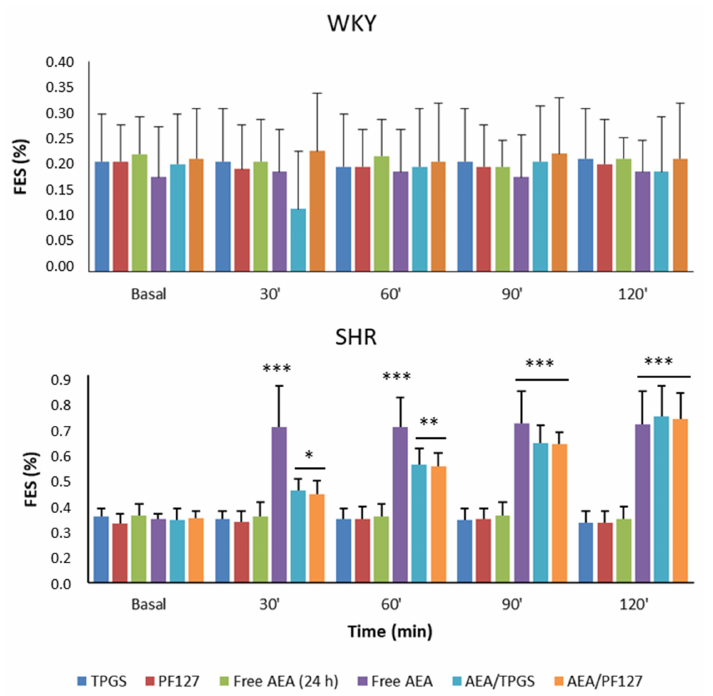
Figure 8. Percentage of the fractional excretion of sodium, measured in WKY and SHR rats, at basal conditions (control) as well as at 30, 60, 90, and 120 min after the injection of different treatments: TPGS empty micelles (TPGS), PF127 empty micelles (PF127), AEA non-encapsulated 24 h after its dispersion in an aqueous solution (free AEA, 24 h), AEA non-encapsulated freshly dispersed in aqueous solution (free AEA), AEA/TPGS micelles (AEA/TPGS), AEA/PF127 micelles (AEA/PF127). n = 3. * p < 0.05; ** p < 0.01; *** p < 0.001, all versus basal.